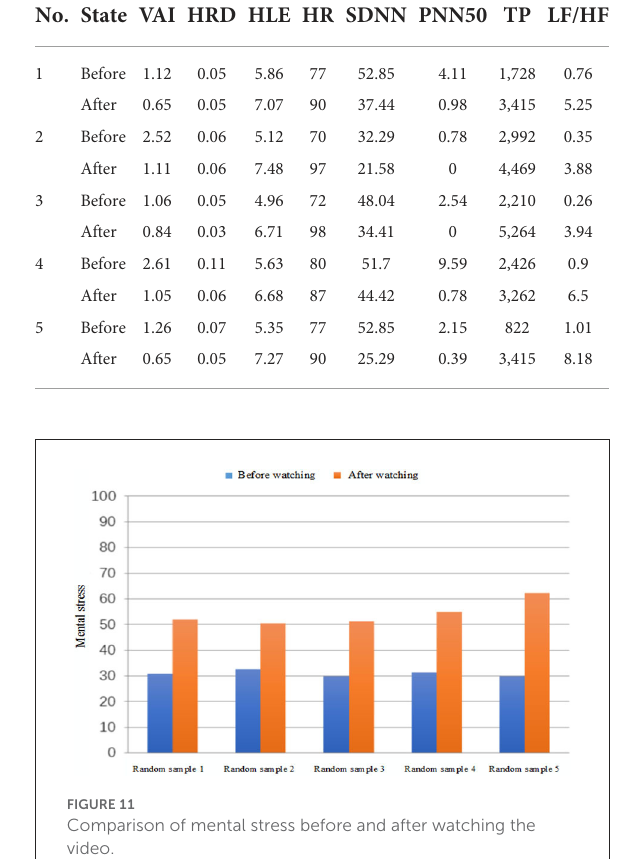
TABLE 4 Comparison of random experimental data and pressure index before and after watching.